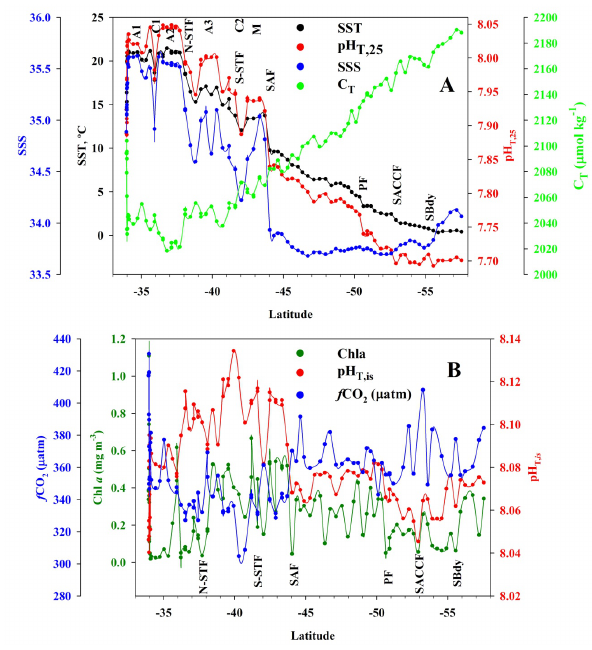
Fig. 2. (A) The sea surface temperature (SST), salinity (SSS), total dissolved inorganic carbon ( C T , µmolkg − 1 ) and pH in total scale at 25 ◦ C (pH T , 25 ) along the cruise track for samples analysed over the upper 10m. The figure shows the position of the major frontal zones during the BONUS GoodHope cruise. (B) Surface ocean Chloro- phyll a , partial pressure of CO 2 in seawater expressed as fugacity, f CO 2 , sw (µatm) and pH in total scale at in situ conditions, pH Tis .